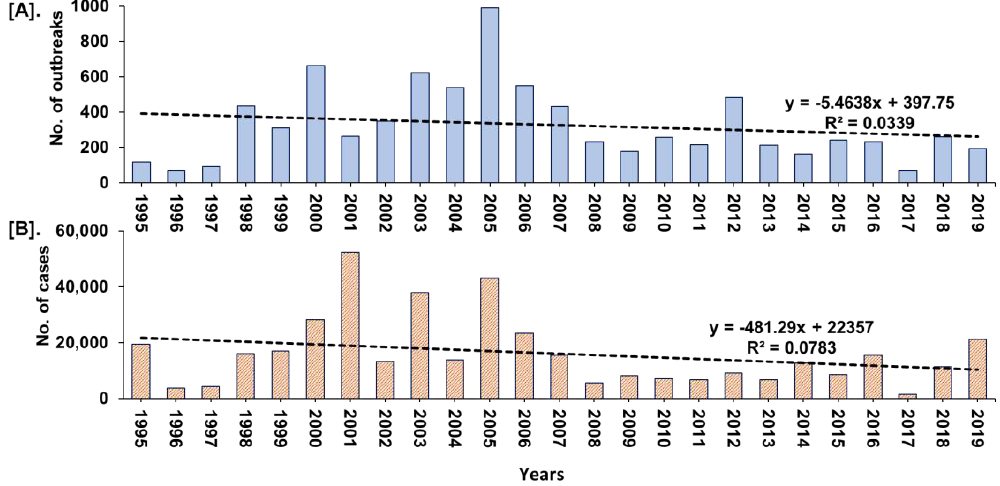
Figure 5. Year-wise trend analysis of cumulative PPR reports in India (1995–2019). ( A ). Outbreaks ( B ). Cases. A gradual increase in outbreaks and cases since 1995 and the highest numbers between 2000 and 2007, with a declining trend from 2005 was observed.